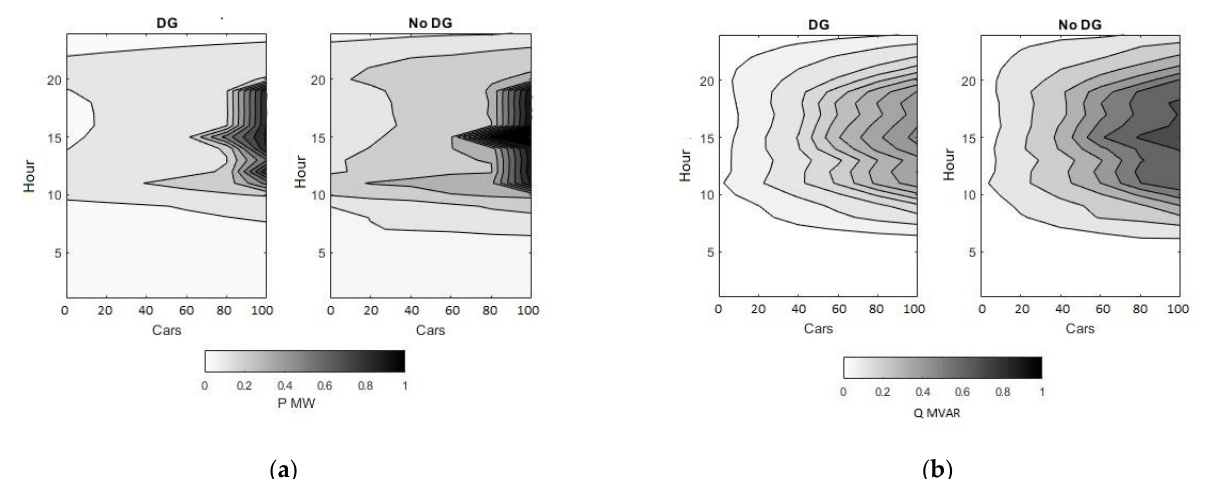
Figure 8. ( a ) Maximum active power requirements of the complete network v. ( b ) Maximum reactive power requirements of the peak network. Both values are aggregated at the primary windings of the transformer and plotted against EV penetration.